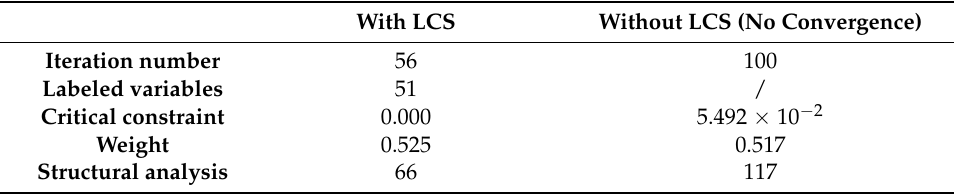
Figure 14. Iteration history for the 63-bar truss. Table 3. Optimization results of the 63-bar truss.